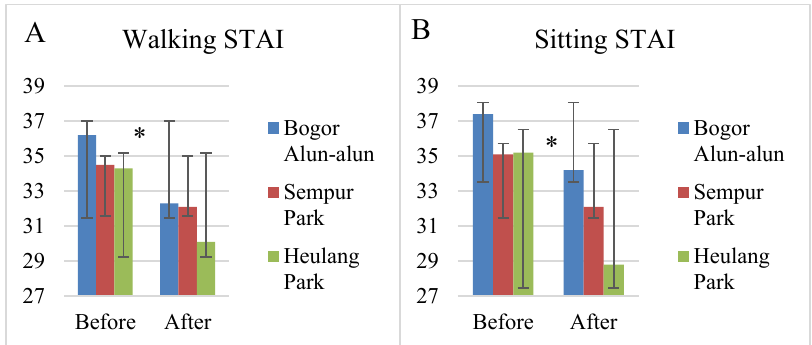
Figure 7. Comparison of the STAI subscale results before and after walking/relaxed sitting at the three locations. (A) Walking. (B) Relaxed sitting. Note: (*) p - value ≤0